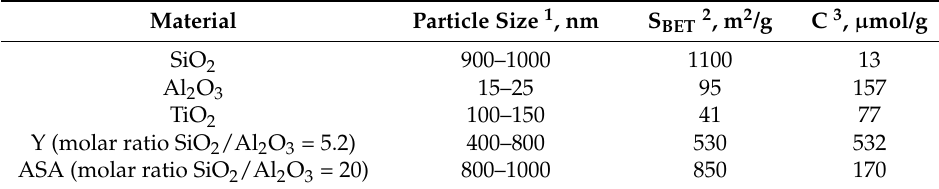
Table 3. Characteristics of the additive